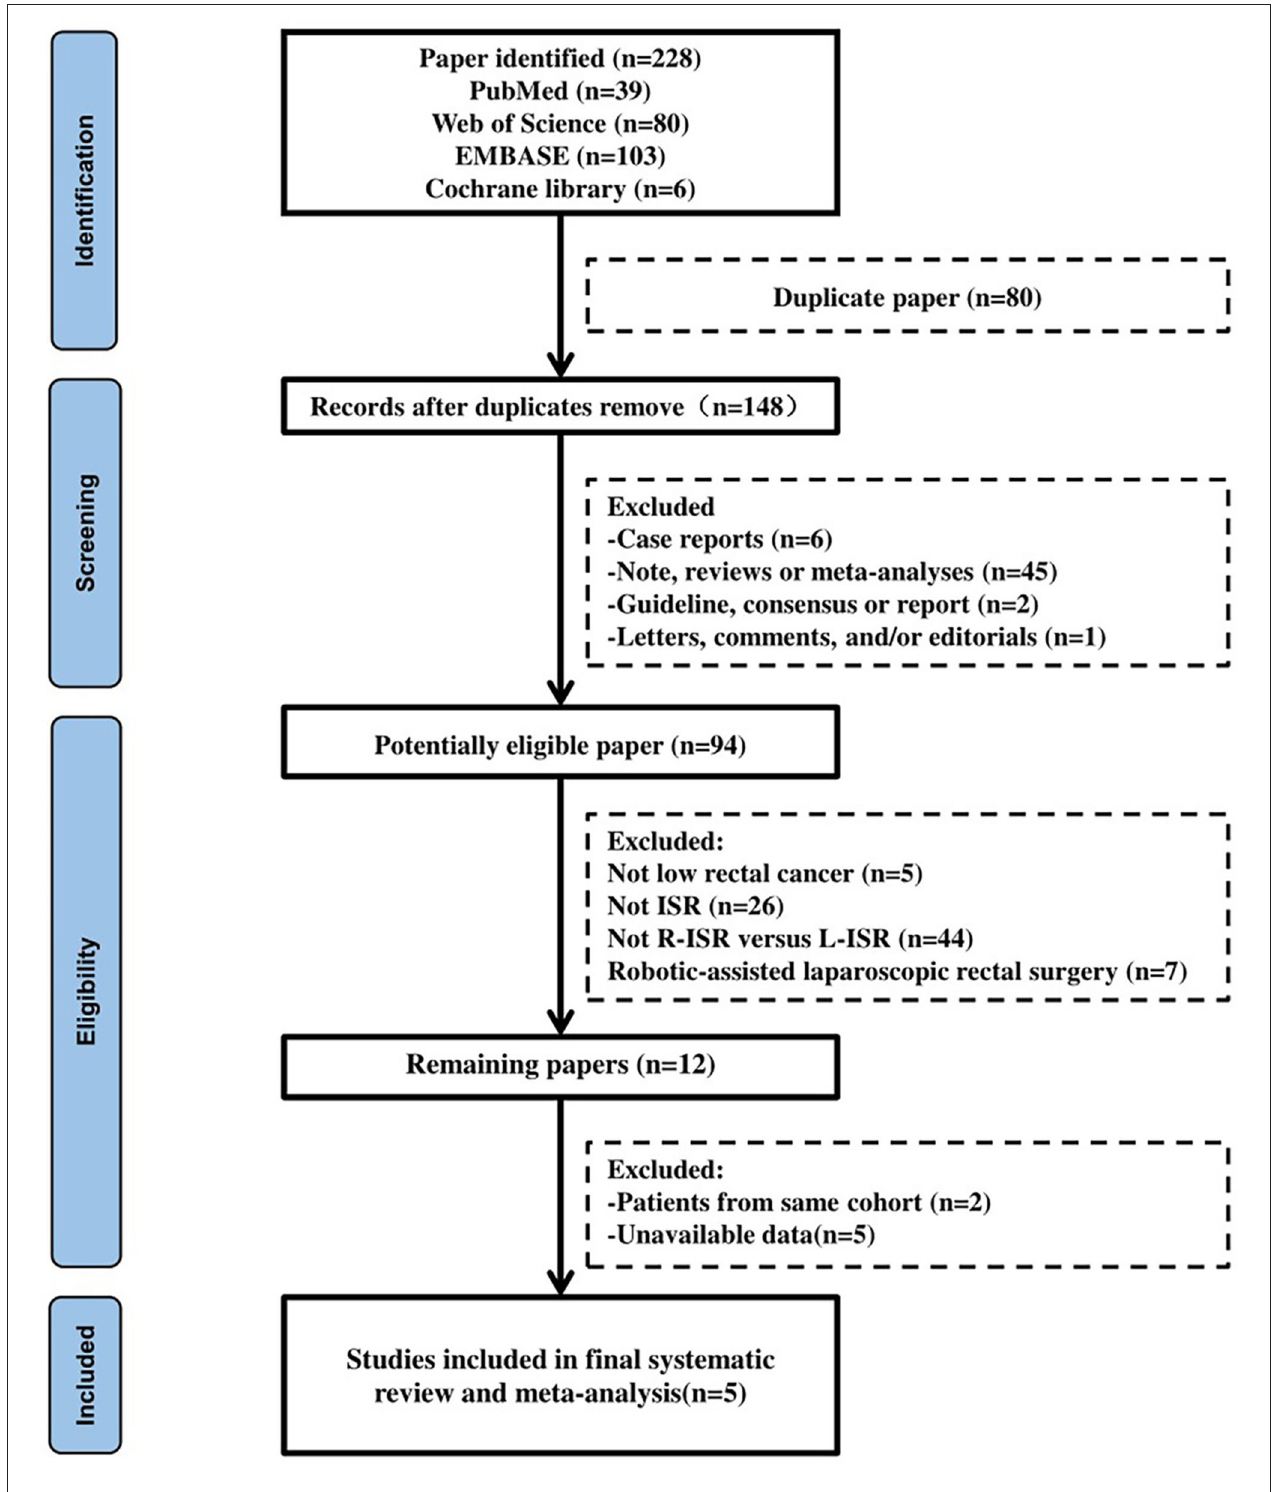
FIGURE 1 | Flow diagram of study inclusion.